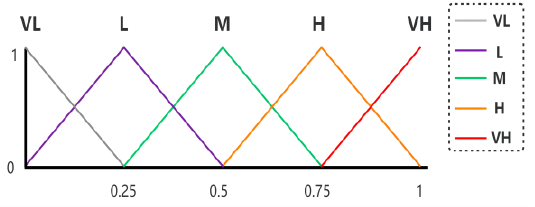
Figure 2. Linguistic term set of five labels used in the Numbeo database.